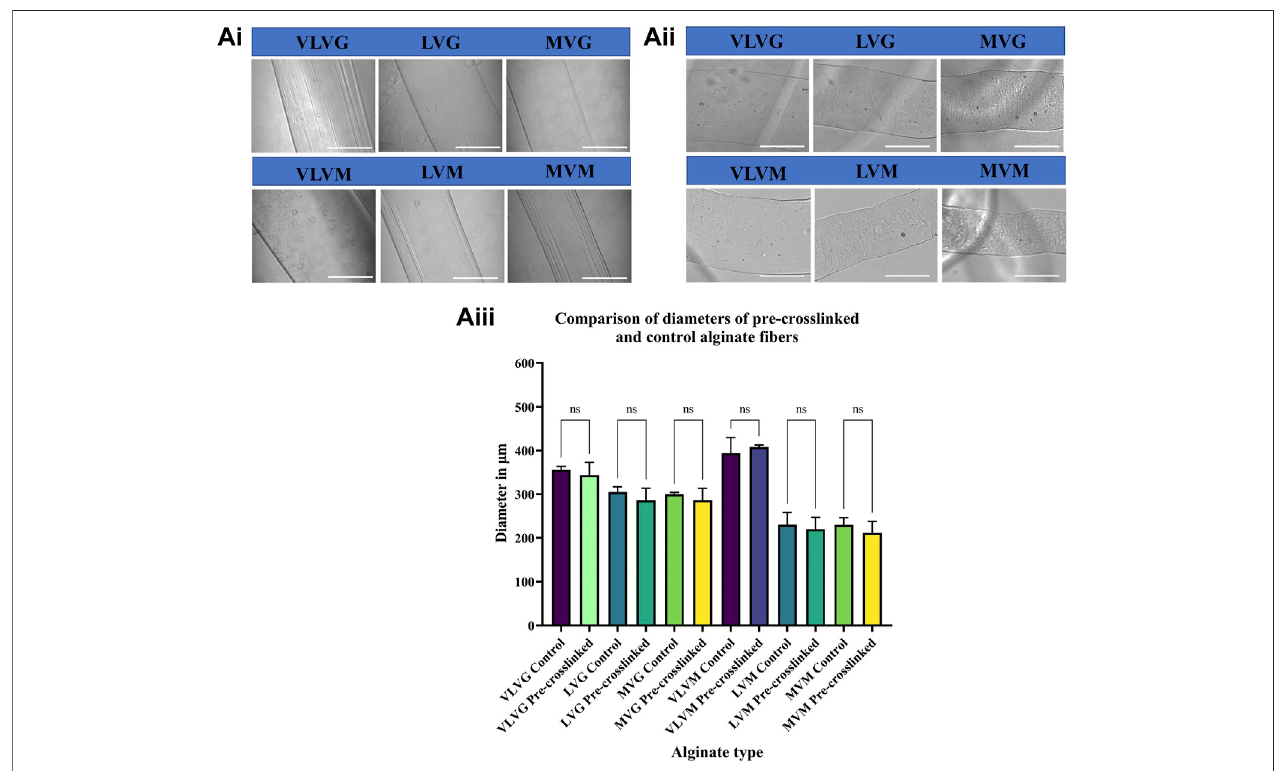
FIGURE2| Theeffect ofalginatemolecularweight, G:Mratioand pre-crosslinking onthediameterofwet spunalginate fi bers.Fibers wereformed bywetspinning priortobeingimaged.Controlalginate fi bers arepresented in (Ai) ,pre-crosslinked alginate fi bers are presented in (Aii) , comparison ofdiametersofpre-crosslinkedand control alginate fi bers is presented in (Aiii) . Values are expressed as mean ± SD from six separate